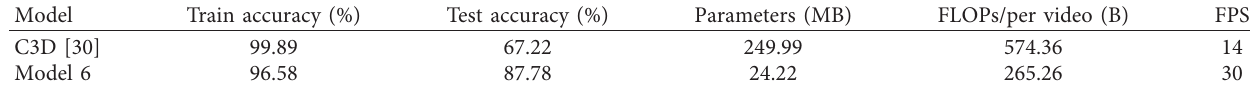
Table 3: Model 6 versus the C3D model in detection accuracy and